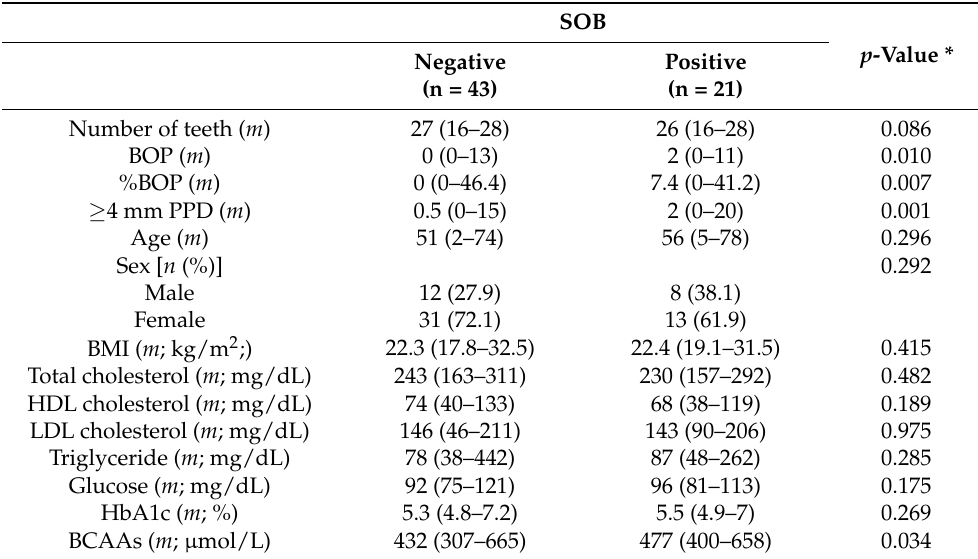
Table 1. Characteristics of participants according to the SOB-test